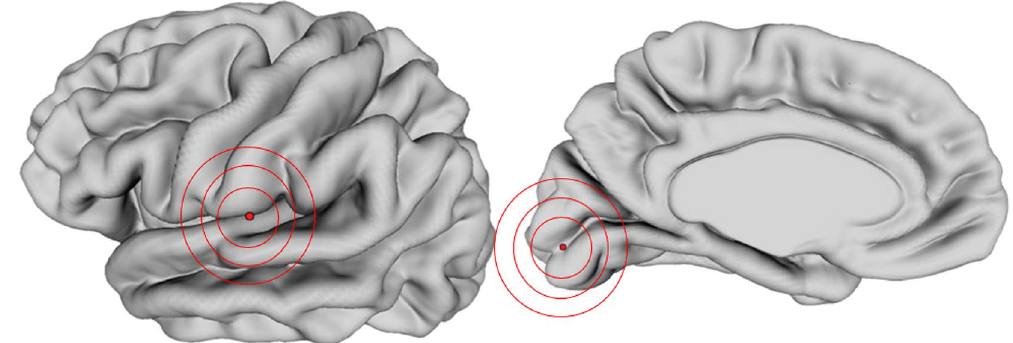
Figure 6. Seed locations are shown here in the left hemisphere, marked with a red dot. The corresponding vertex point was used in the right